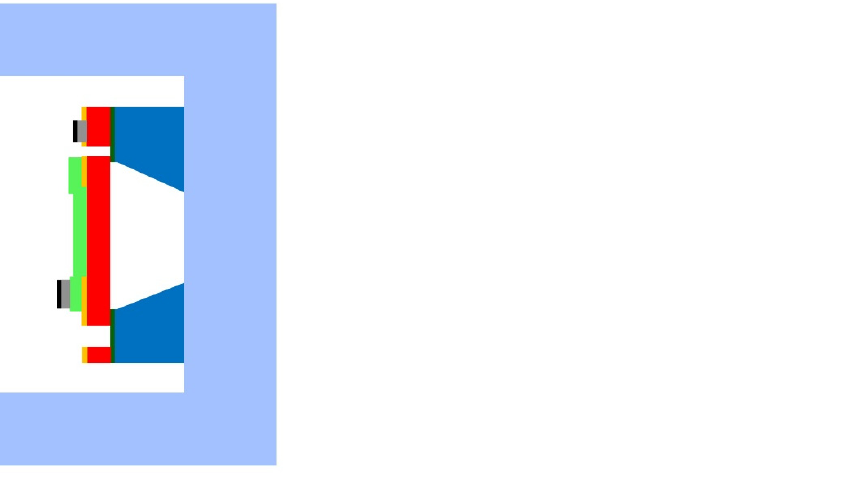
Figure 7. Schematic illustration of the pMUT within the cavity (dimensions are not in scale). Table 5. Values of the lumped parameters for the coupling cavity and the pMUT.